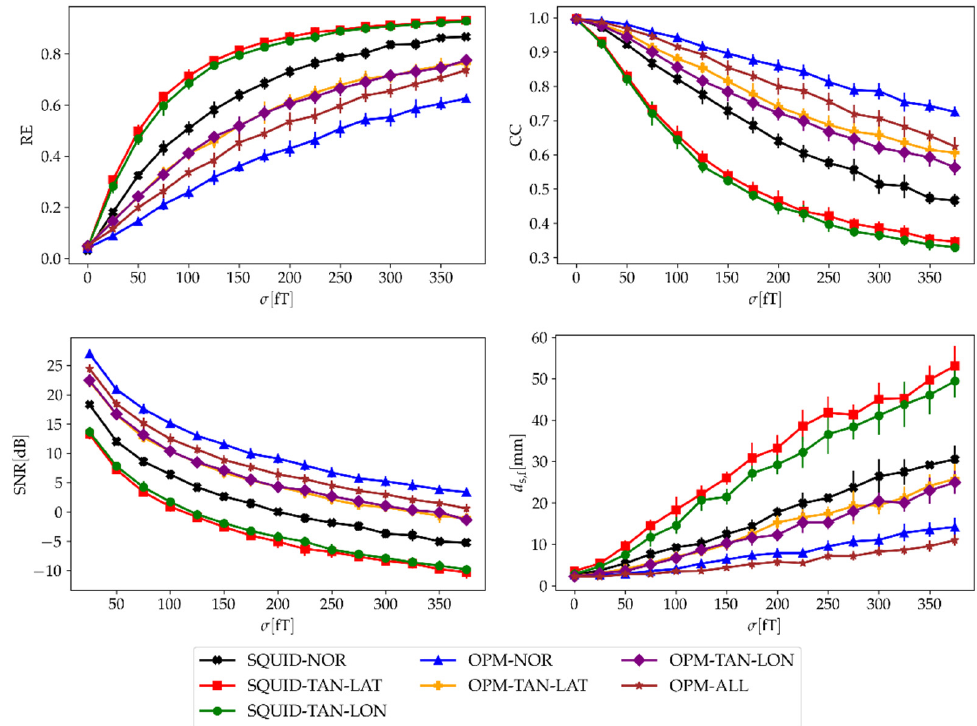
Figure 5. Evaluation parameters (RE, CC, SNR, and d s,f ) averaged over all 100 time samples and eight subjects in relation to the strength ( σ ) of the ambient noise for four different OPM-MEG configurations. The dipoles’ strength of spontaneous brain noise was q spont = 0. Vertical lines represent the standard deviation between subjects.